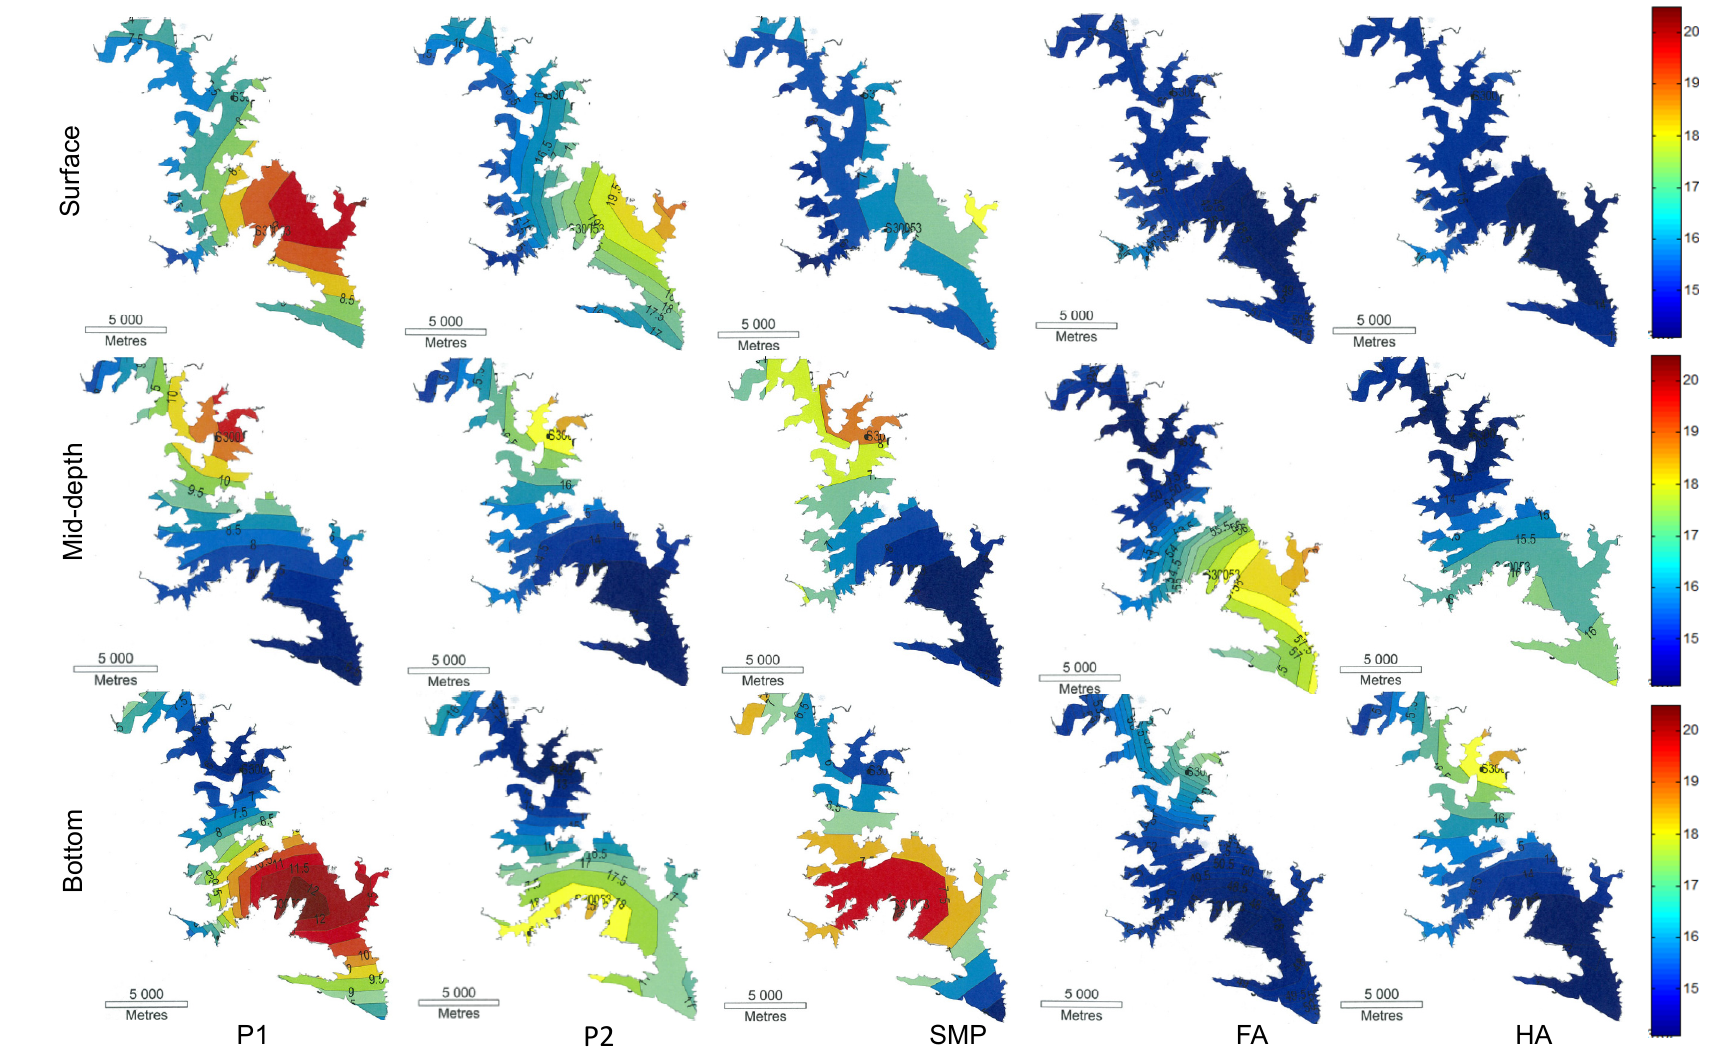
Figure 4. Contour diagrams of the fluorescence spectral intensity of flood water for the surface, mid-depth and bottom of water across the lake based on the fluorescence area of each region (colours represent fluorescence